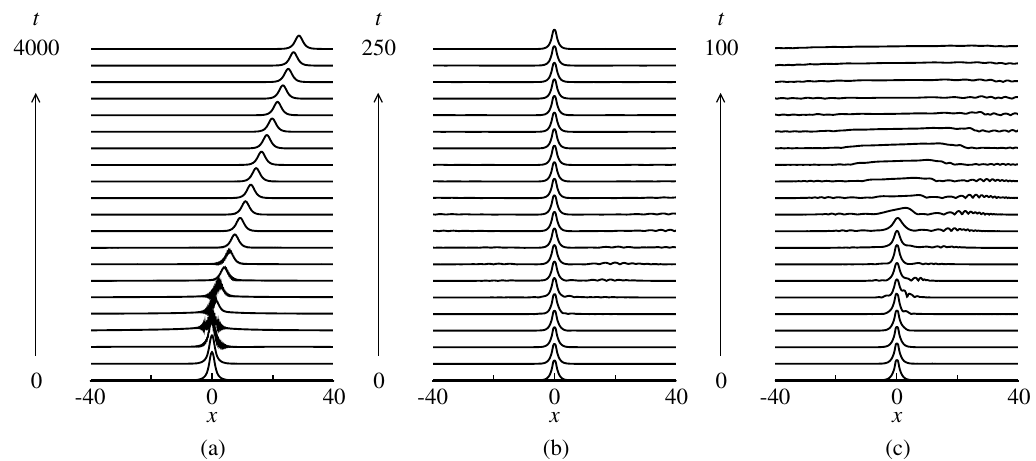
Figure 7. Propagation of unstable asymmetric solitons for λ = 0.1, m = 0.1. ( a ) Type 1 soliton with ω = − 0.67, η = 0.09, ( b ) Type 2 soliton with ω = 0.2, η = 1.0 and ( c ) Type 2 soliton with ω = 0.4, η = 1.0. Only the u 1 − component is